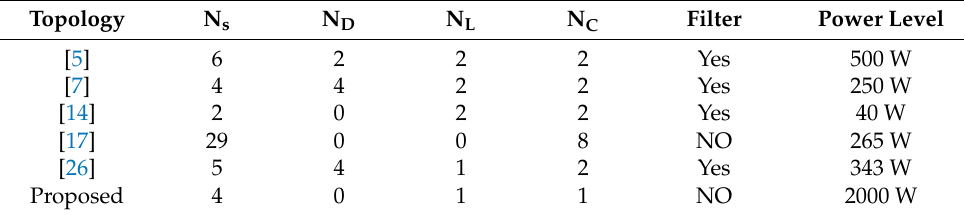
Table 2. Comparative